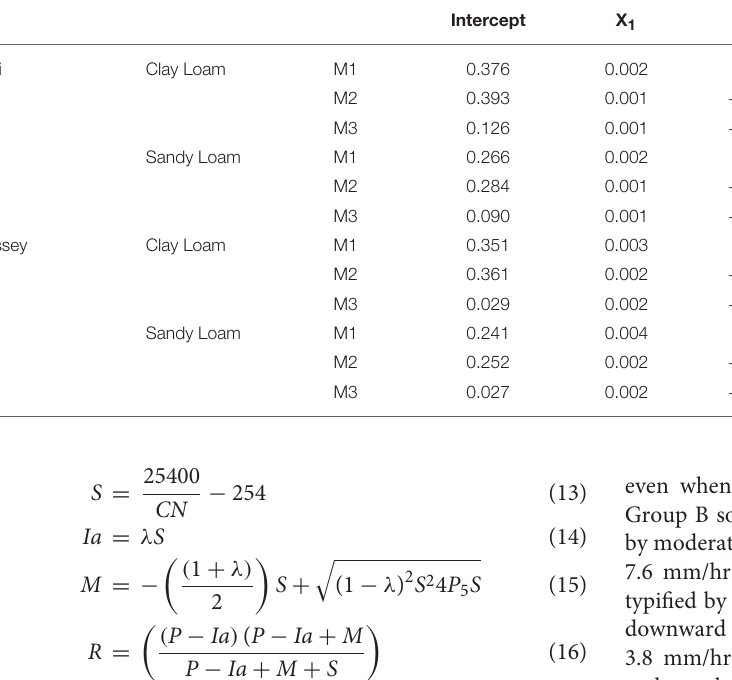
TABLE 2 | Coefficients of the three linear models and the root mean squared error (RMSE), mm d − 1 , for the calibration (1961–2000) and validation (2001–2015) periods. Case